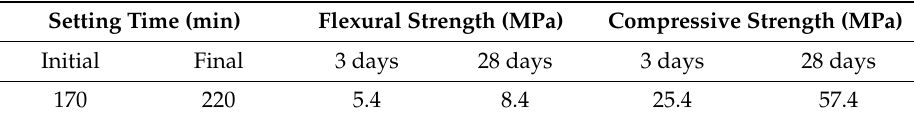
Table 2. Physical properties of cement.